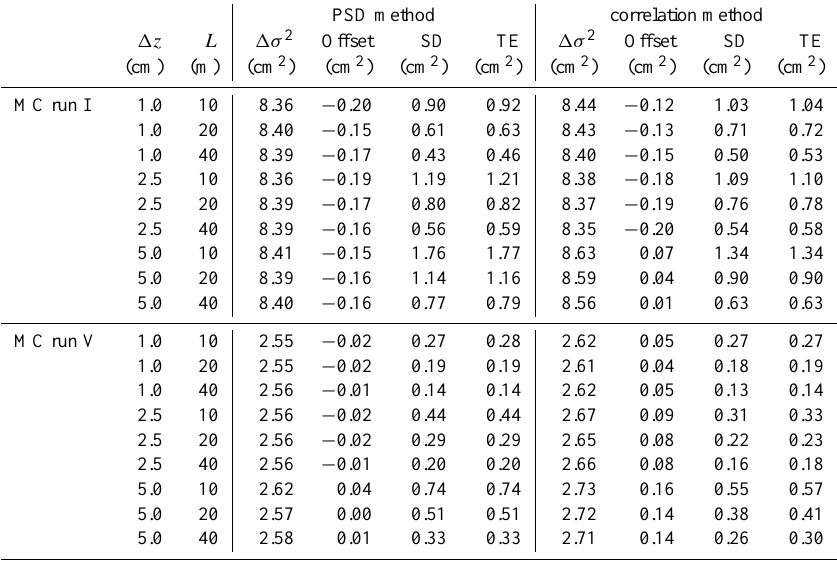
Table 4. Sensitivity of the two methods to sample size (cid:49)z and section length L given for Holocene (MC run I) and glacial (MC run V) conditions at the EDML drill site